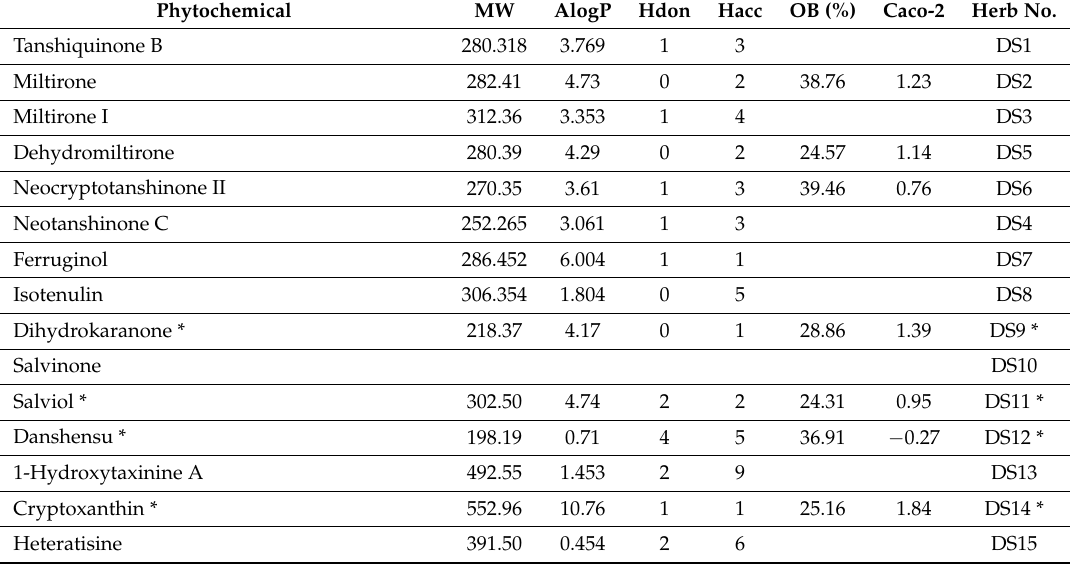
Figure 5. The workflow of the network pharmacological study of JGB. Table 1. The 56 compounds from Danshen, Wuweizi, and Yunzhi and their corresponding molecular properties, OB and Caco.